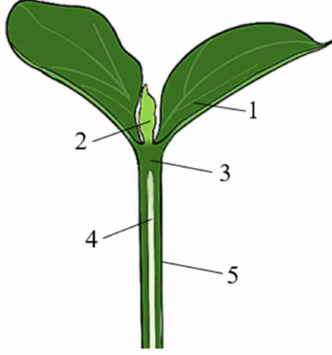
Figure 1. Pith cavity structure of the rootstock seedling: (1) cotyledon, (2) true leaf, (3) solid structure, (4) pith cavity, and (5)